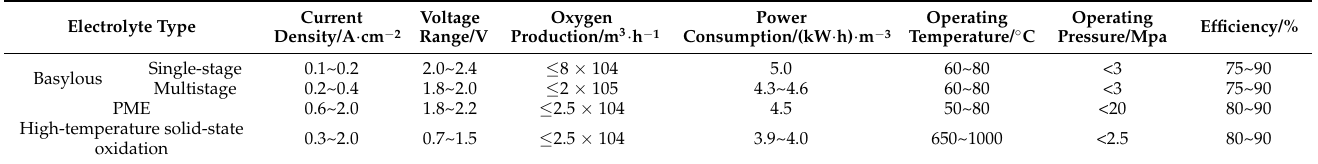
Table 6. Characteristic parameters of electrolyzers